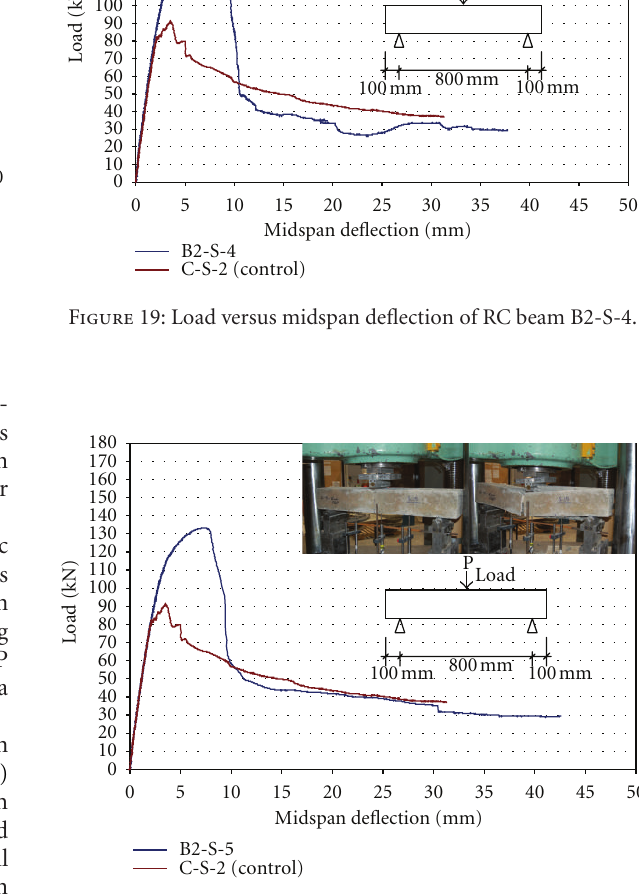
Figure 20: Load versus midspan deflection of RC beam